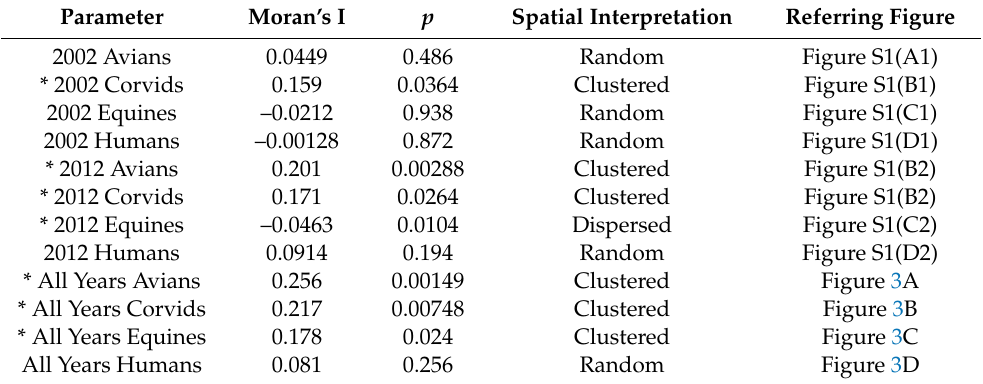
Table 4. Spatial relationship for WNV cases in avians, corvids, equines, (controlled by rate) and humans (controlled by incidence) for all years (2001–2016, pooled) and years 2002 and 2012, respectively.